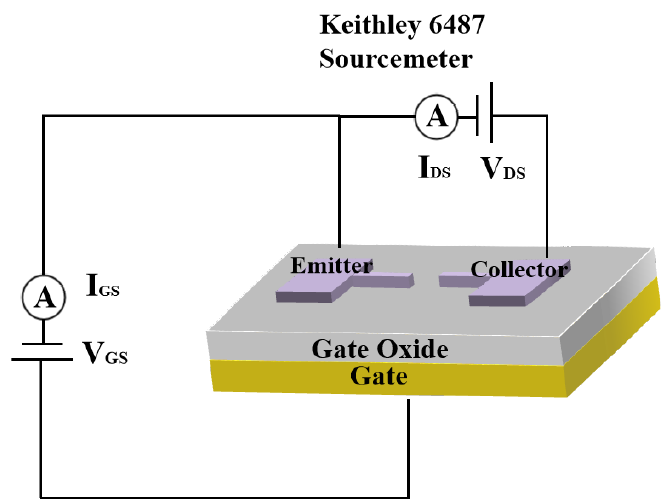
Figure 5. Schematic diagram of the test setup.